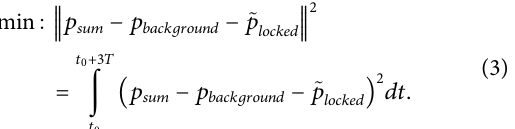
Figure 3 . From Eq. 1 , we can see that: 1) When a motor is connected to the power network, the angular velocity of the rotor equals zero ( ω = 0). The p locked ( t ) reaches the maximum earlier than the current of each phase reaches the maximum value. p locked ( t ) is independent of the mechanical load and the closing angle λ ; the coef fi cients C , Γ , a 1 , and ϕ only determined by the equivalent circuit parameters of the induction motor (see Supplementary Appendix SA for details); i.e., these parameters re fl ect the electrical features of a motor, which means that there exists only one rotor-locked power curve p locked ( t ) for a certain motor. 2) C is the DC component coef fi cient of p locked ( t ) , which indicates the steady value that p locked ( t ) can reach. a 1 is the amplitude coef fi cient of the AC component; a 1 is close in size but opposite in sign to C because p locked ( 0 ) (cid:1) 0 , as shown in Figure 3 . 3) Γ is the decay time constant of the AC component of p locked ( t ) , which is mainly determined by the equivalent